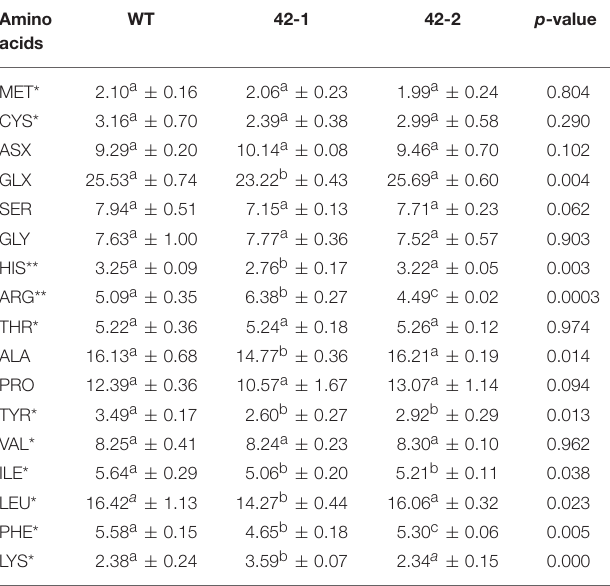
TABLE 1 | A comparison of the protein-bound amino acid content of the wild-type (WT) and transgenic sorghum genotypes 42-1 and 42-2, presented on a dry weight basis in mMol/100g wholegrain flour.